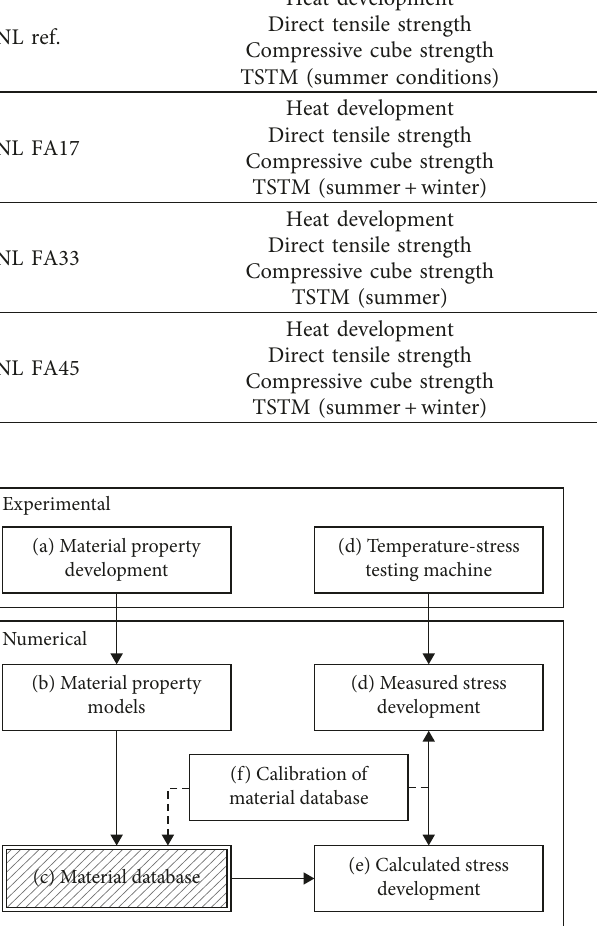
Figure 3: Flow chart of EAC design